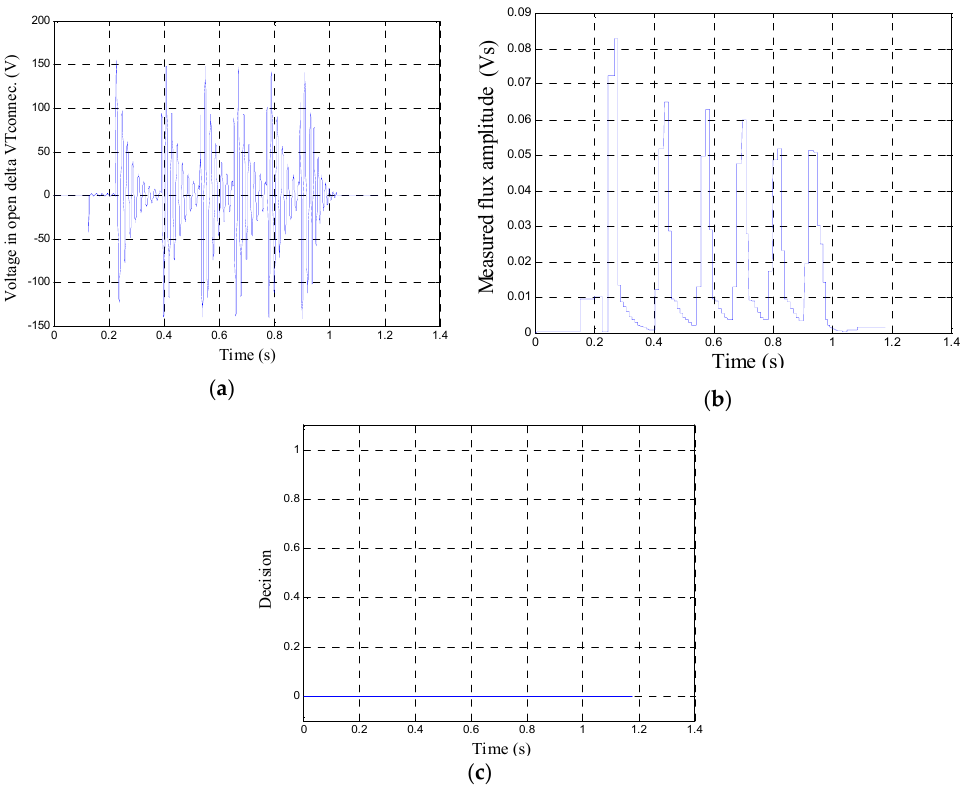
Figure 11. Recorded fault case no.3: ( a ) voltage in open delta VT connection; ( b ) measured flux amplitude; ( c ) proposed algorithm operation.